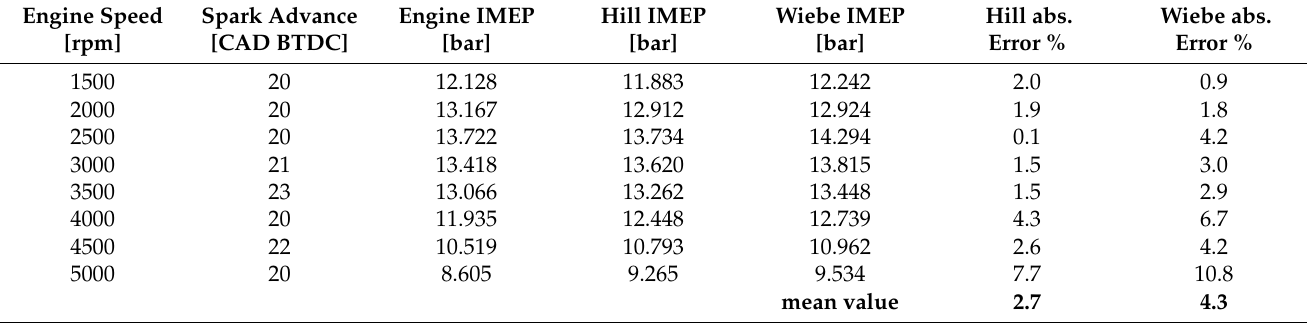
Table 10. Experimental and simulated IMEP with absolute prediction errors (60% NG; MAP = 1.4 bar).